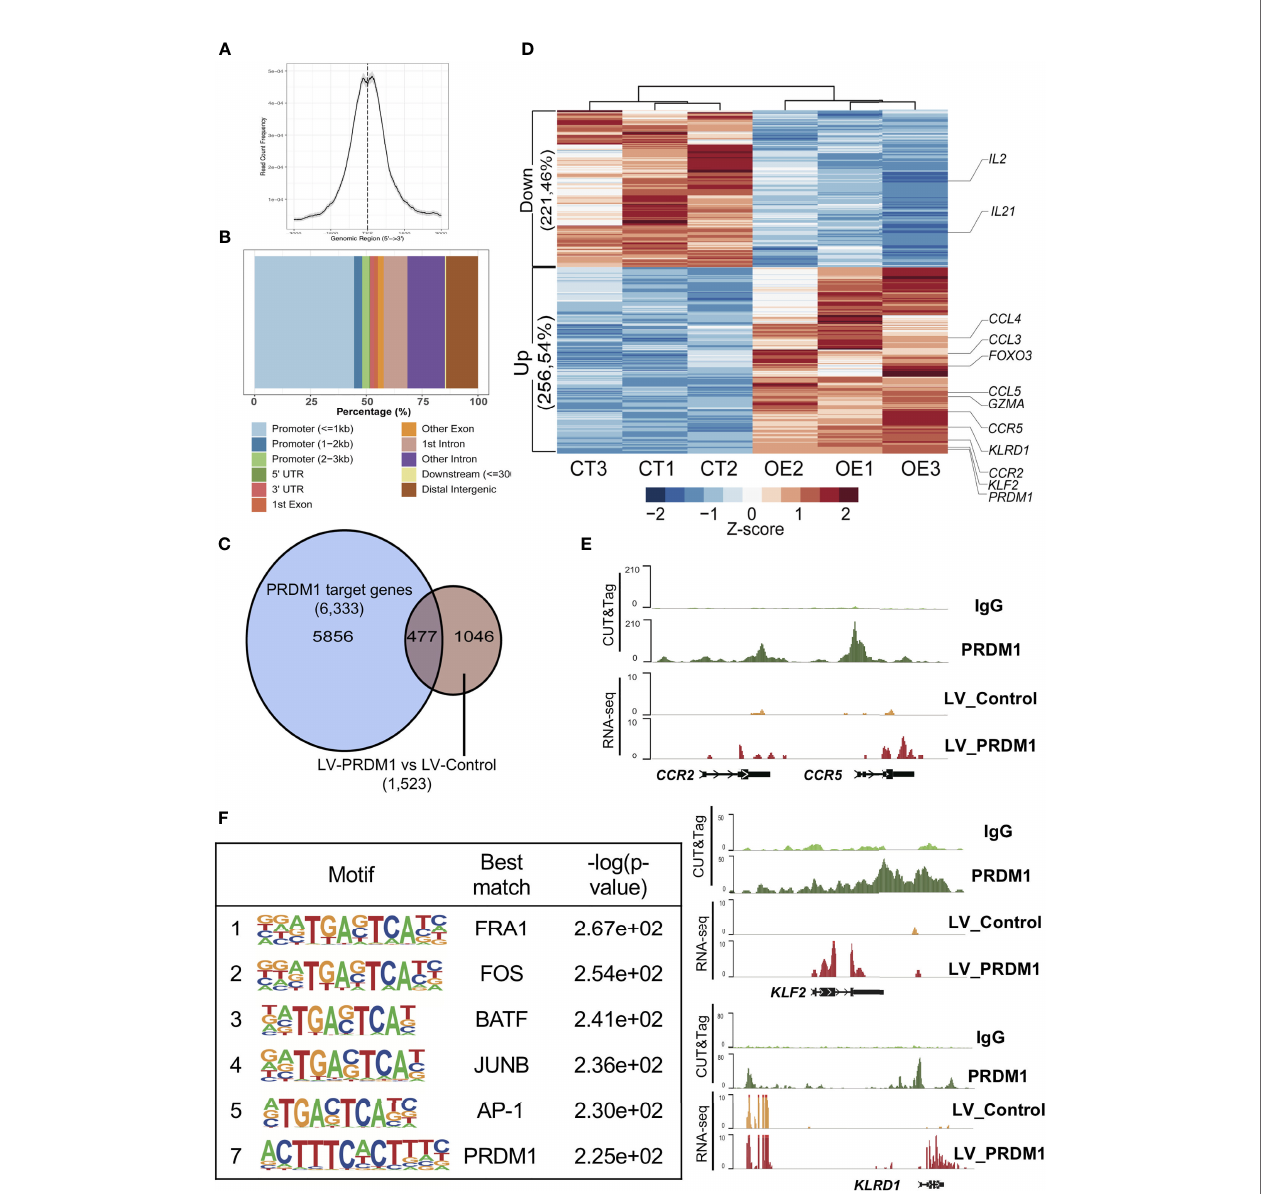
FIGURE 3 | PRDM1 directly upregulated T cell inhibitory gene expression in primary T cells. (A) Aggregate plot of PRDM1 binding site around transcription start sites. (B) Locations of PRDM1 binding sites. (C) The overlap between PRDM1 target genes and differential expression genes in PRDM1 -overexpressing T cells compared with control T cells. (D) Heatmap showed PRDM1 directly regulated differential expression genes in PRDM1 -overexpressing T cells (OE group) compared with control T cells (CT group). FDR q-value < 0.05, |log 2 fold change| > 1. (E) WashU browser views showed PRDM1 biding sites (CUT&Tag) and related gene expression level (RNA-seq). (F) Top 7 enriched transcription factor motifs in the PRDM1 CUT&Tag peaks are